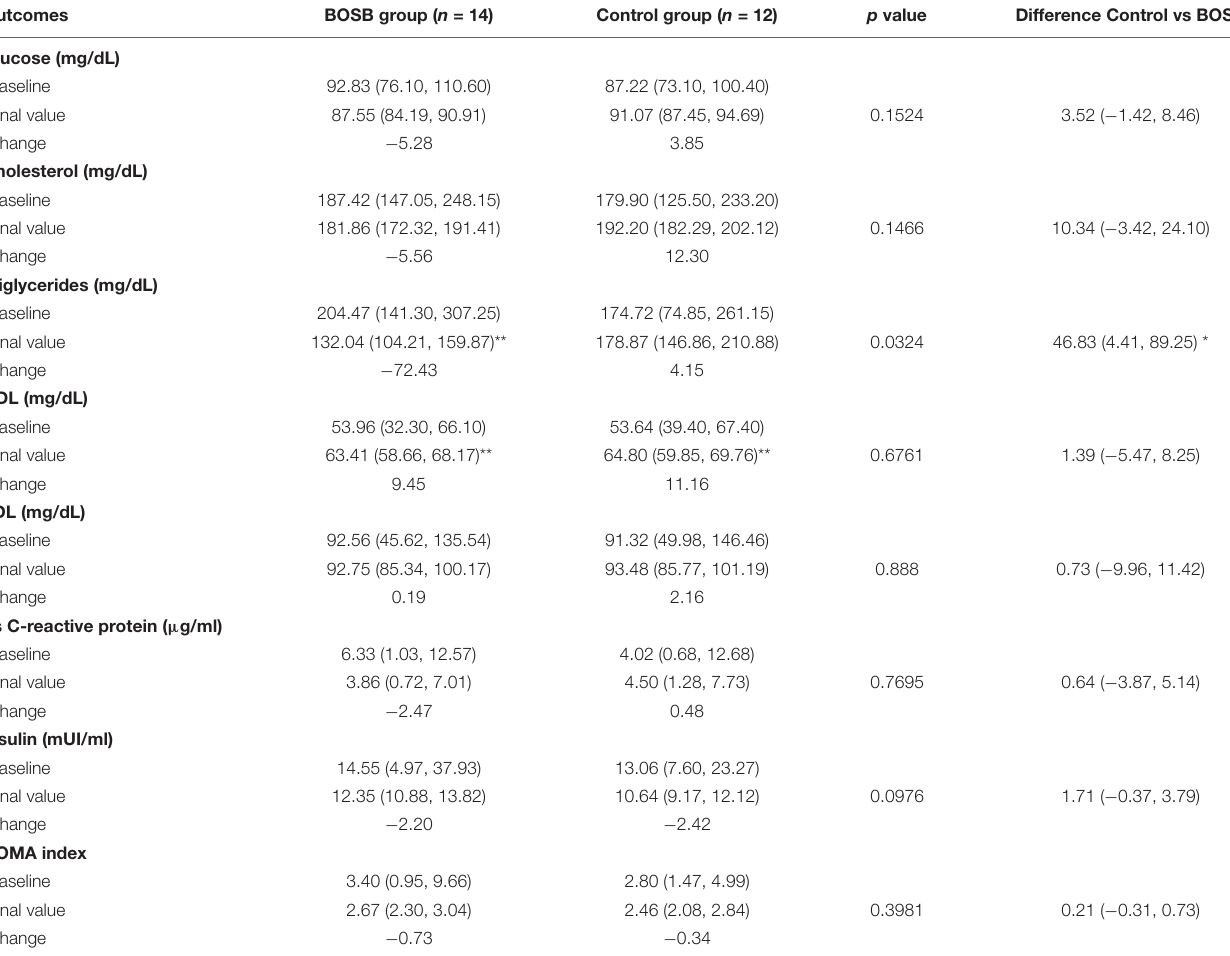
TABLE 4 | Changes in biochemical markers after 8-week consumption of